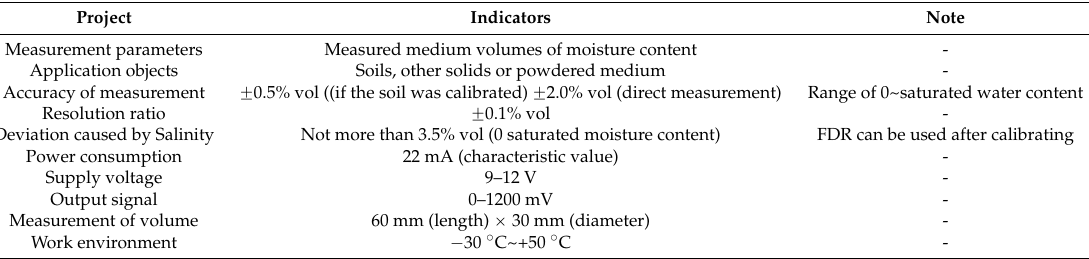
Table A1. Main technical parameters of FDR